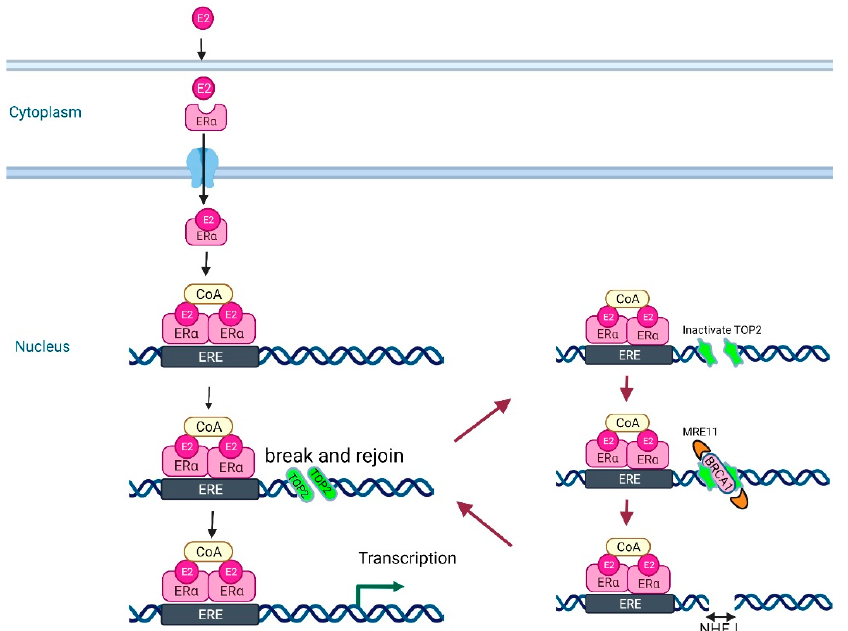
Figure 4. Binding of estrogens (E2s) to estrogen receptor (ER α ) transiently induces DNA double-